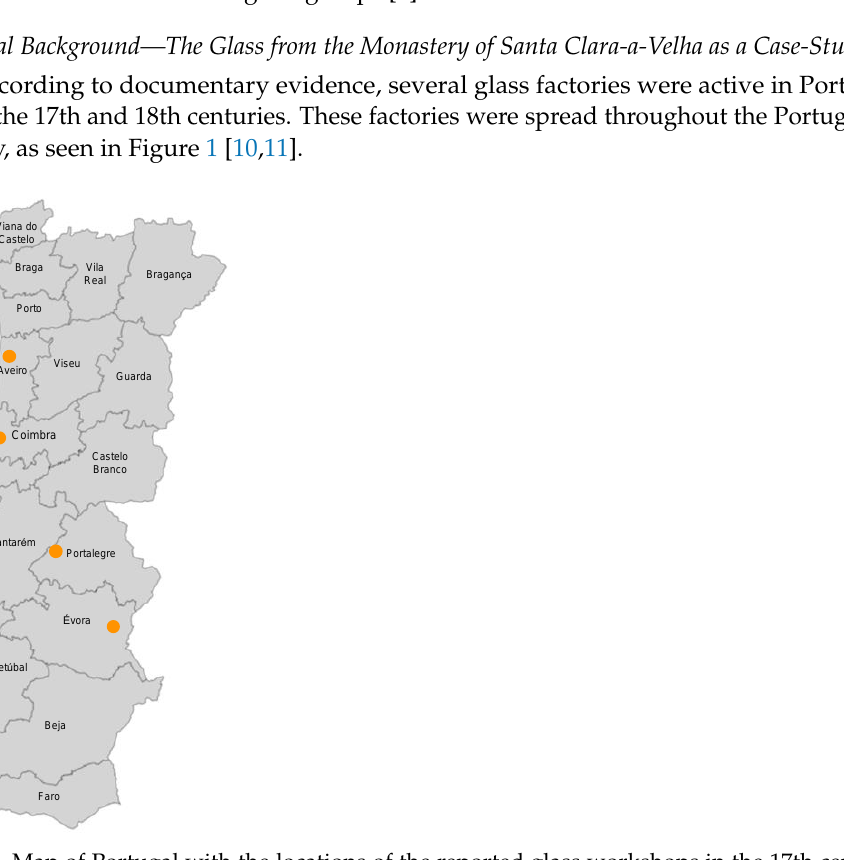
Figure 1. Map of Portugal with the locations of the reported glass workshops in the 17th century (orange dots). Adapted from [10].